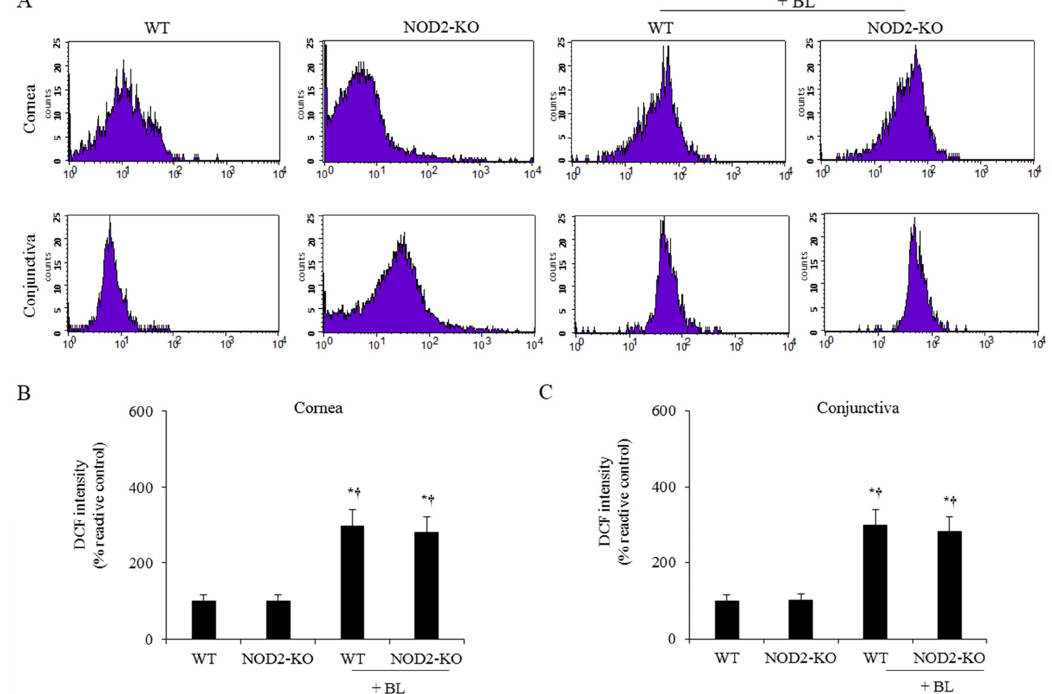
Figure 1. 2 ′ ,7 ′ -Dichlorodihydrofluorescein diacetate (DCF-DA) assay of representative photograph ( A ) and the mean of staining in cornea ( B ) and conjunctiva ( C ) of the WT, NOD2-KO, WT+BL, and NOD2-KO+BL groups, after 10 days of blue light exposure. * p < 0.05 vs. WT; † p < 0.05 vs. NOD2-KO. WT, wild type; BL, blue light; NOD2-KO, nucleotide-binding oligomerization domain 2 knock-out.